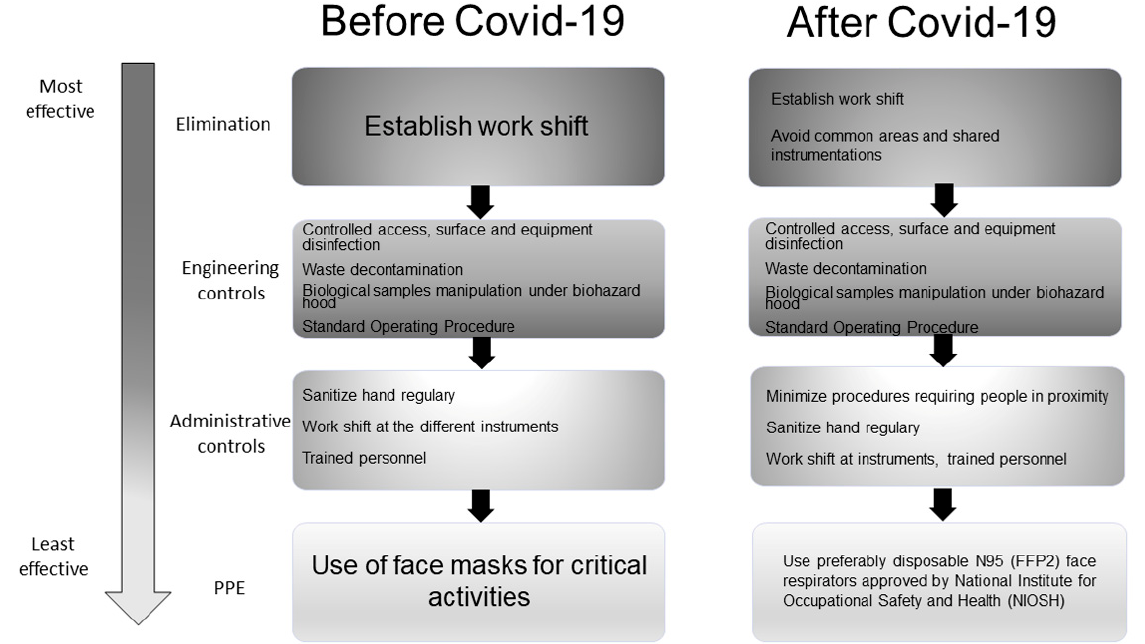
Figure 6. Hierarchy of Controls to identify the “research-lab” best practices for COVID-19 control. Depicted with a vertical arrow list, the most effective controls are on the top side, whereas the least effective controls are on the bottom. Left part: existing measures; Right part: emergency measures.